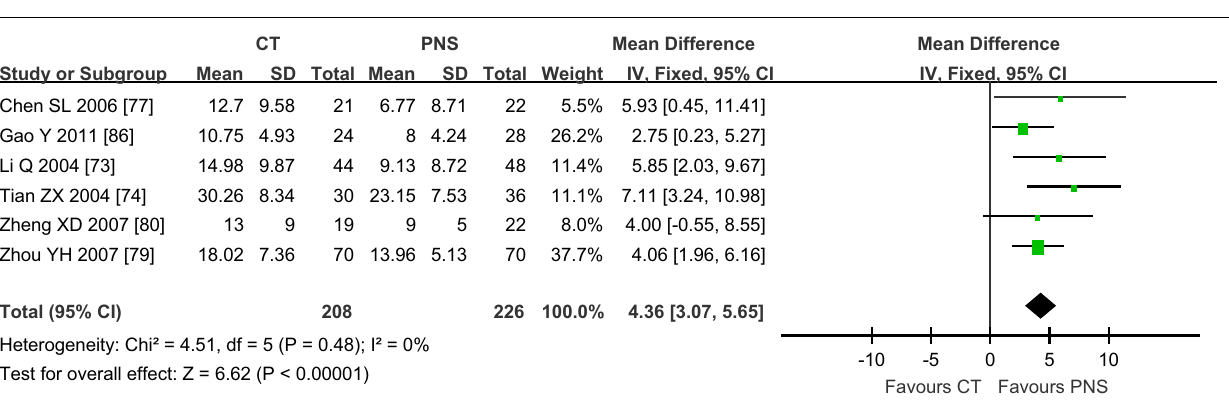
FIGURE 3 | Meta-analyses of the neurological deficit score (NDS) .The overall effect showed significant statistical difference in NDS between the PNS and CT groups (MD = 4.36; 95% CI = 3.07, 5.65; P <0.00001). No heterogeneity ( P = 0.48) was found in NDS (6 trials). PNS, Panax notoginseng saponin; CT, Current